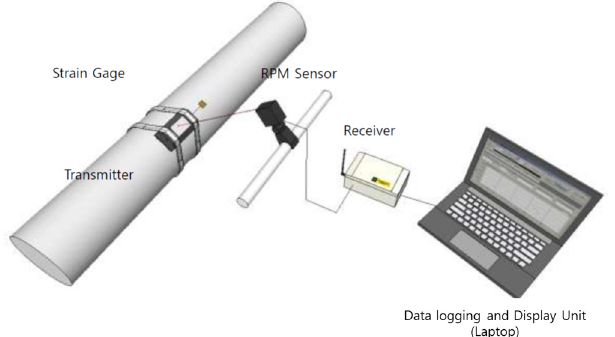
Figure 1. Configuration of the strain gauge-type measurement system.